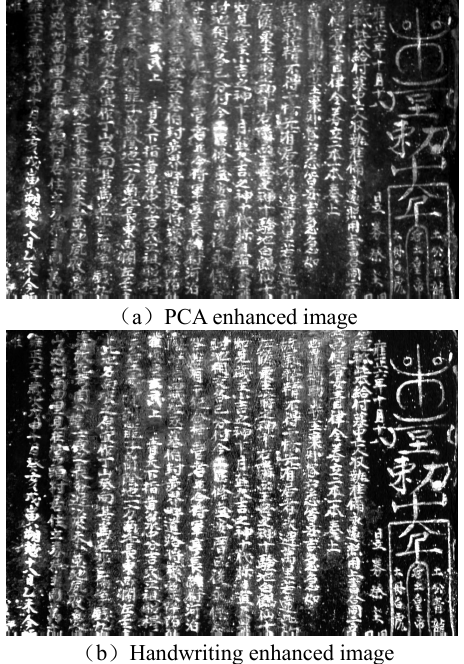
Figure 5. Comparison of handwriting enhanced results